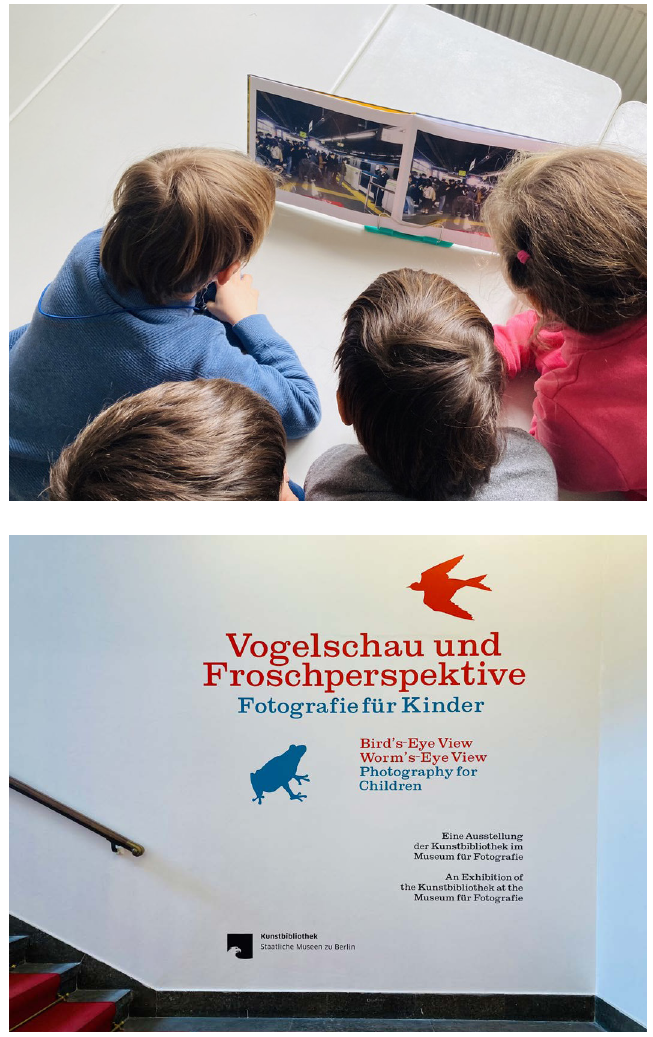
Fig. 9 Photo by Giulia Mirandola.